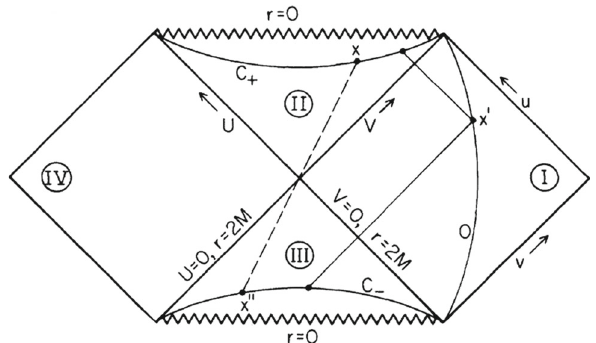
Fig. 2 ThePenrose diagram fortheSchwarzschildgeometry. IndRGT this diagram would correspond to the one described by observers defin- ing the time in agreement with the Stückelberg function T 0 ( r , t ) .